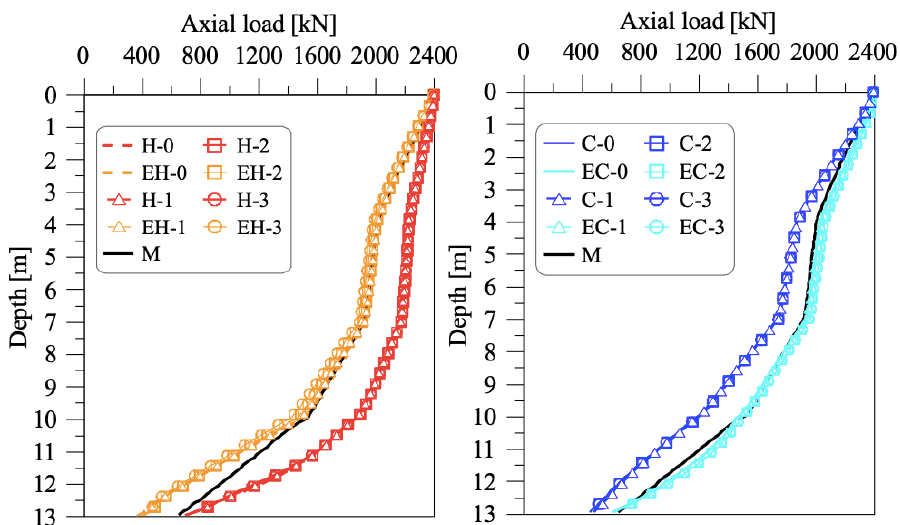
Figure 3. C Axial loads along the pile shaft for di ff erent thermal conductivity of